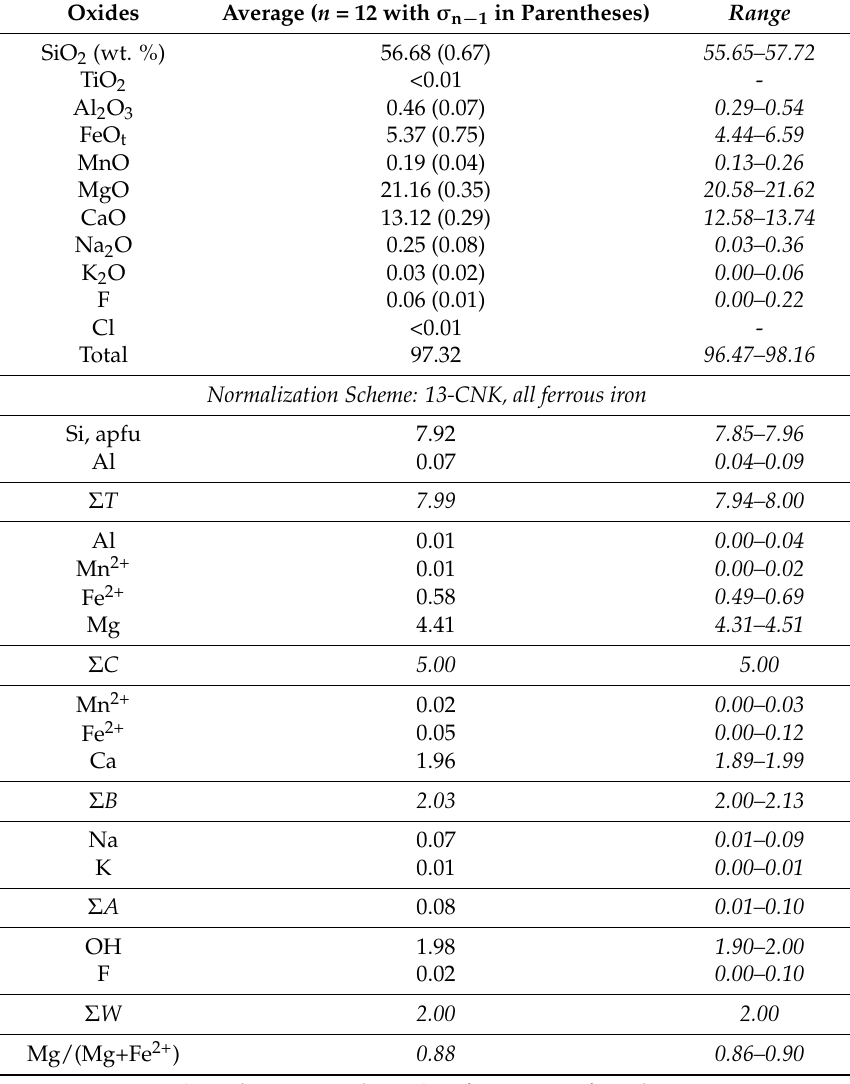
Table 1. Results from Electron Probe Micro-Analysis